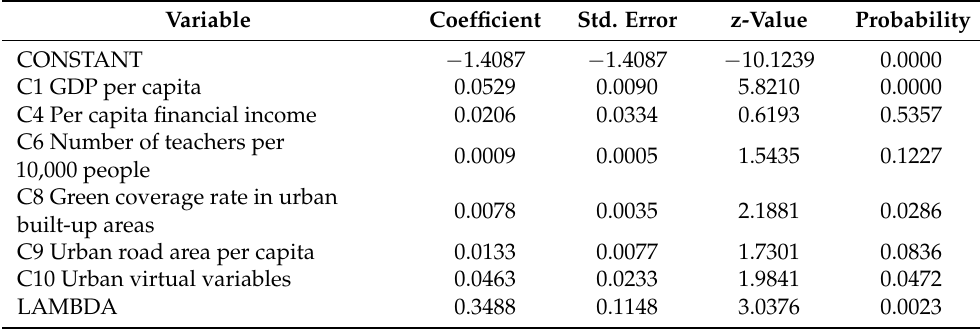
Table 5. Spatial regression results of PLIU coordination degree and impact factors in the